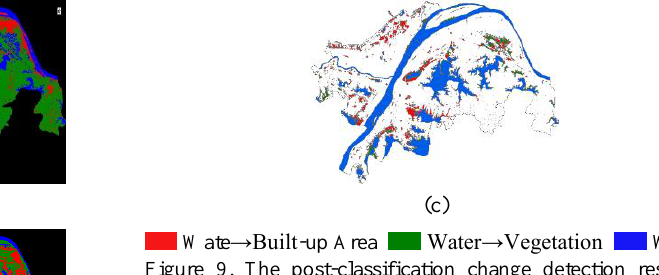
Figure 9. The post-classification change detection results in 2017.